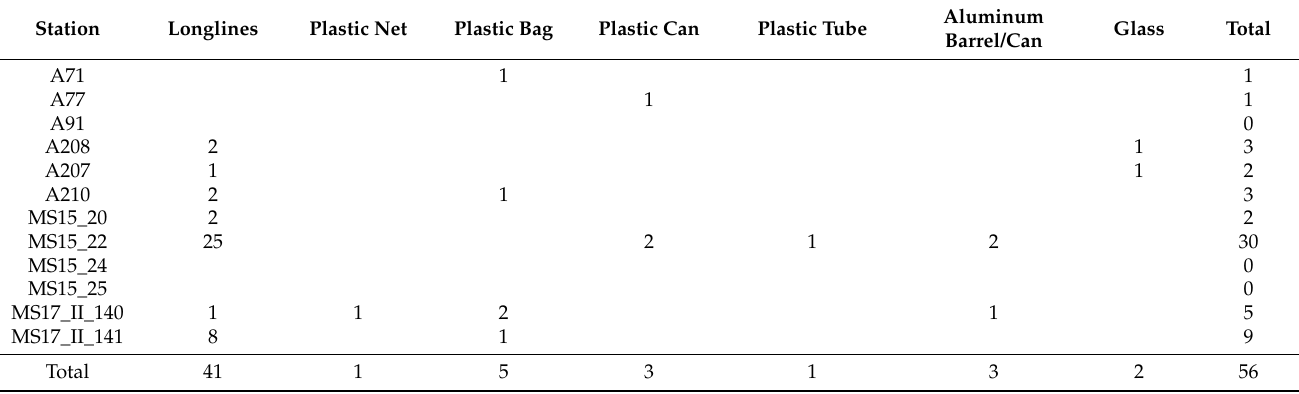
Table 3. Number of litter items identified through ROV